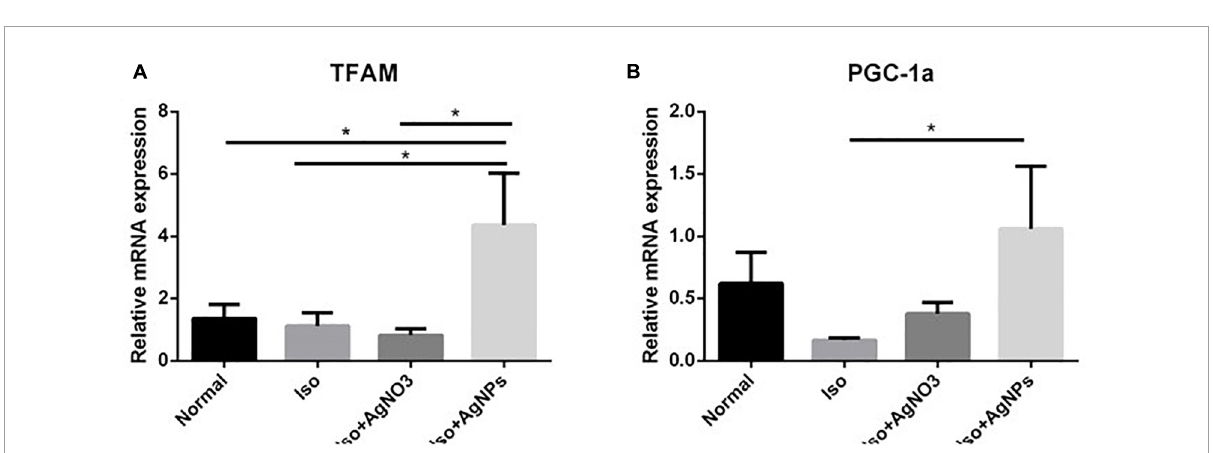
FIGURE7 The effects of AgNO 3 and AgNPs on the mRNA expressions of TFAM (A) and PGC-1 α (B) . Each column represents the mean relative mRNA expression ± SEM of six rats. Data analysis was performed using one-way ANOVA, followed by Tukey multiple comparison test. * P < 0.05. Iso, isoproterenol; AgNO 3 , silver ion; AgNPs, silver